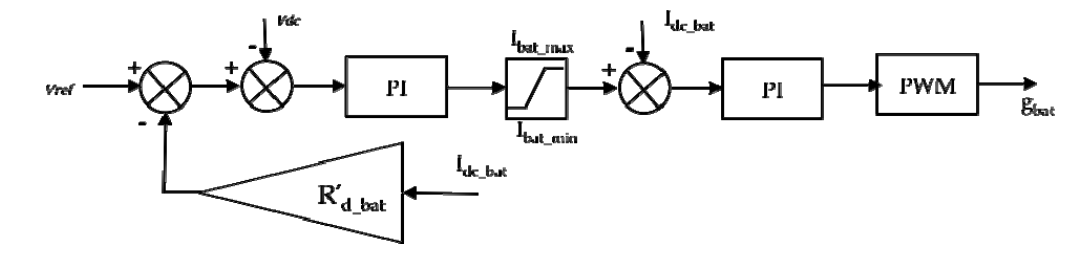
Figure 7. Control diagram of battery converter.